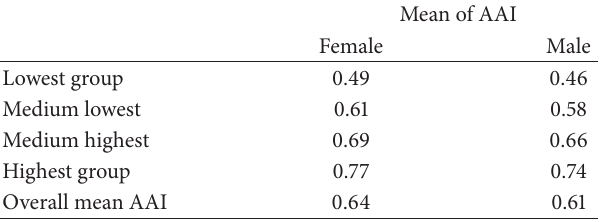
Table 4: Mean level of active ageing of older persons in